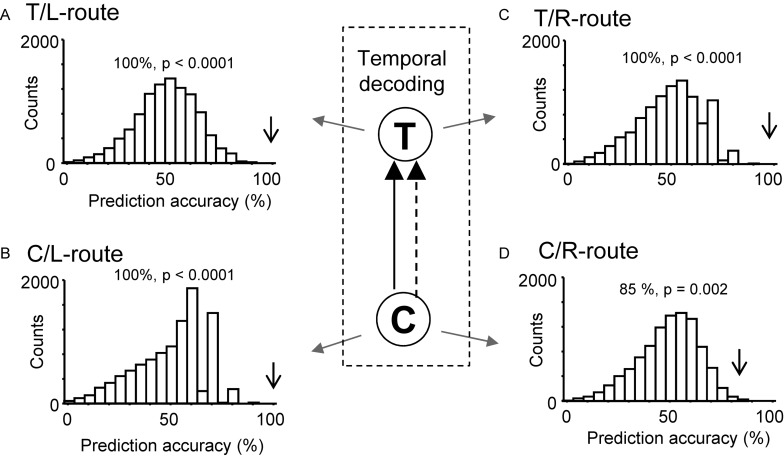
Bayesian decoding of reward delivery from reward-related activity in the control VN task. (A,B) Temporal decoding from reward-related activity around the T- (A) and C- (B) reward area in the left route. (C,D) Temporal decoding from reward-related activity around the T- (C) and C- (D) reward area in the right route. The arrow in each histogram indicates the actual prediction accuracy, while the histogram indicates the chance level distribution obtained using the “bootstrap” procedure (10,000 repetitions). The p-value for each prediction accuracy was calculated as the ratio of the count of the values ≥ the actual prediction accuracy in the chance.